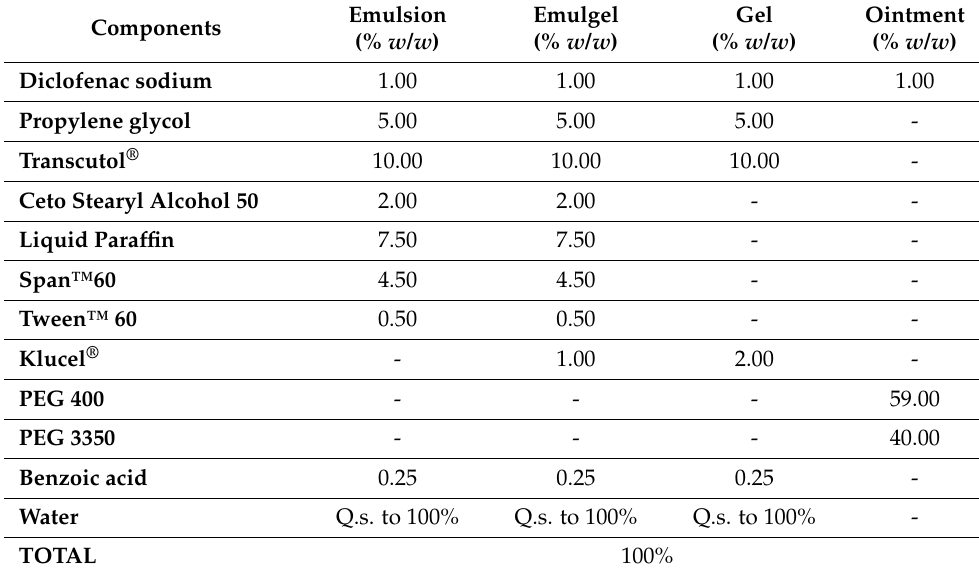
Table 1. Composition of different semi-solid formulations (% w/w